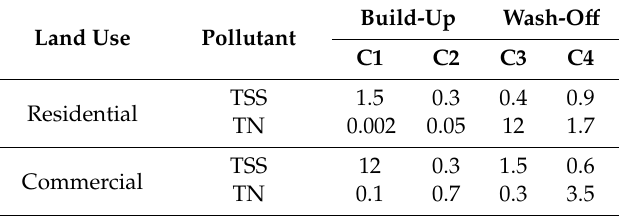
Table 2. Results of buildup and wash-o ff input parameters to calibrate the quality model. Land